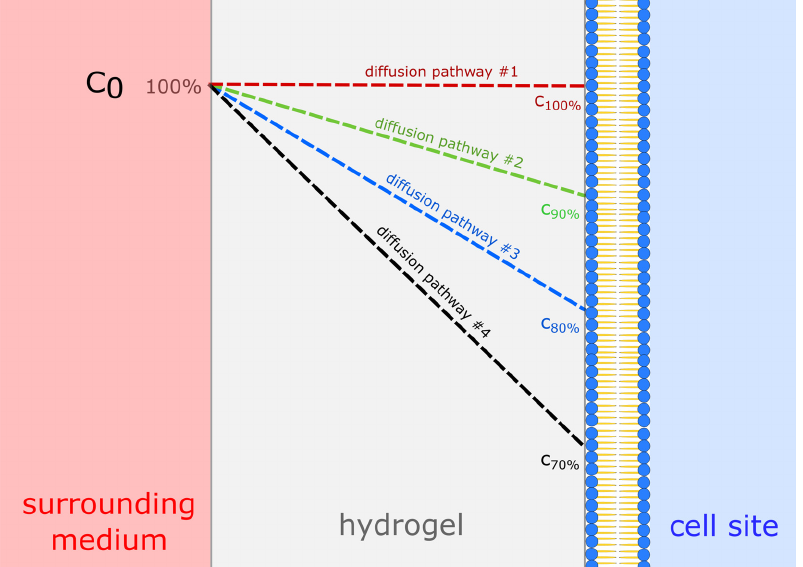
2 Figure 2. Visualization of potential substance distribution profiles dependent on the diffusion path length from the supply site to the cell site, varying from 100% to 70% of the surrounding medium. Thereby, c 0 represents the initial concentration of the surrounding